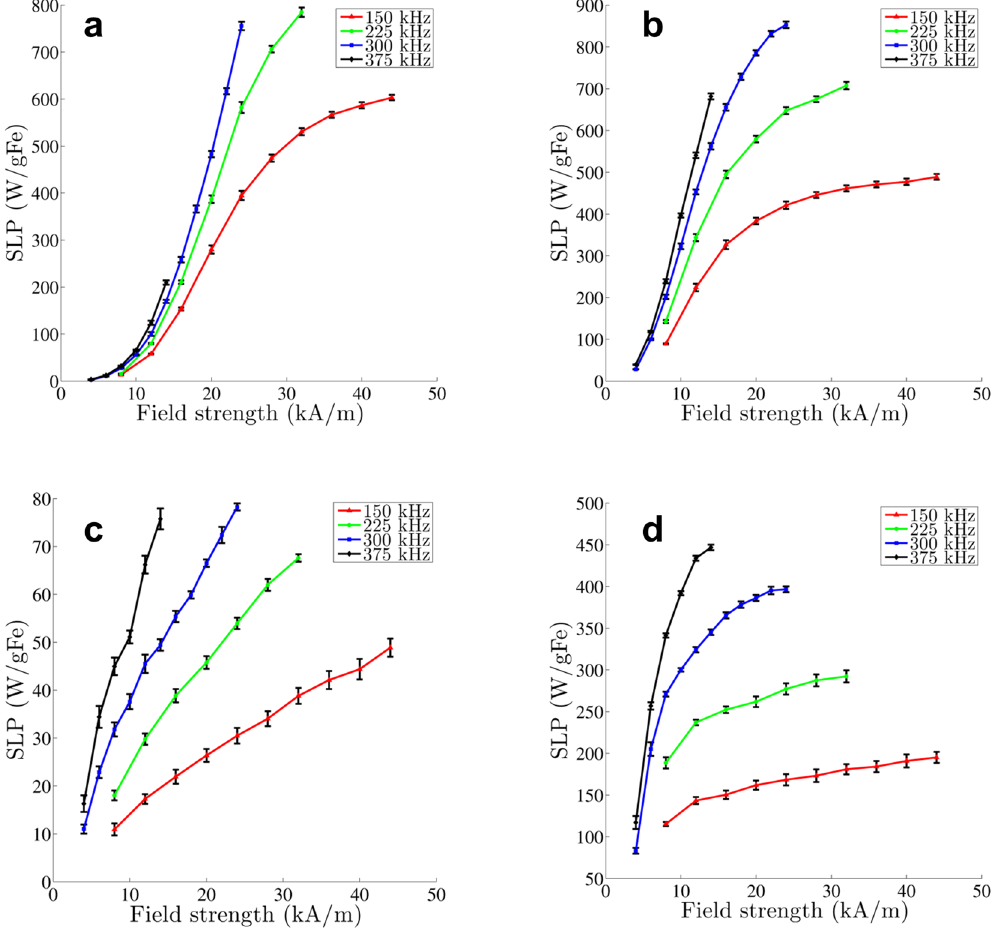
Figure 3. Specific loss power (SLP) measurements versus field strength of four different magnetic nanoparticle solutions ( a : BNF-Dextran, b : JHU, c : nanomag ® -D-spio, d: MnFe 2 O 4 ) at four different frequencies ranging from 150 kHz to 375 kHz. Only the mean SLP value is reported, and the error bars are the standard deviation of all possible SLP